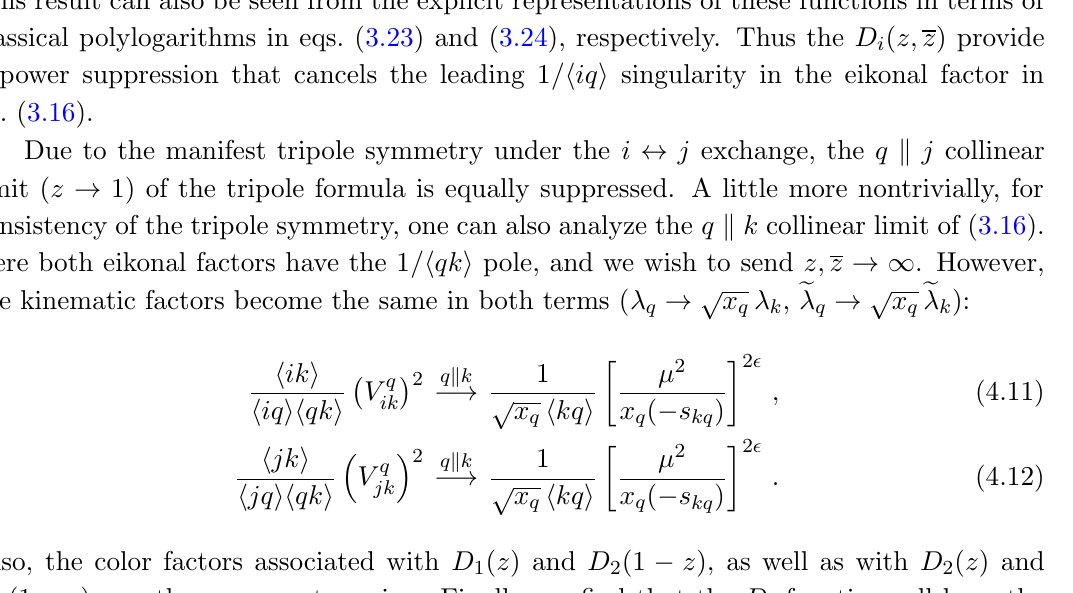
( z; z ( z; z ) and D 1 2